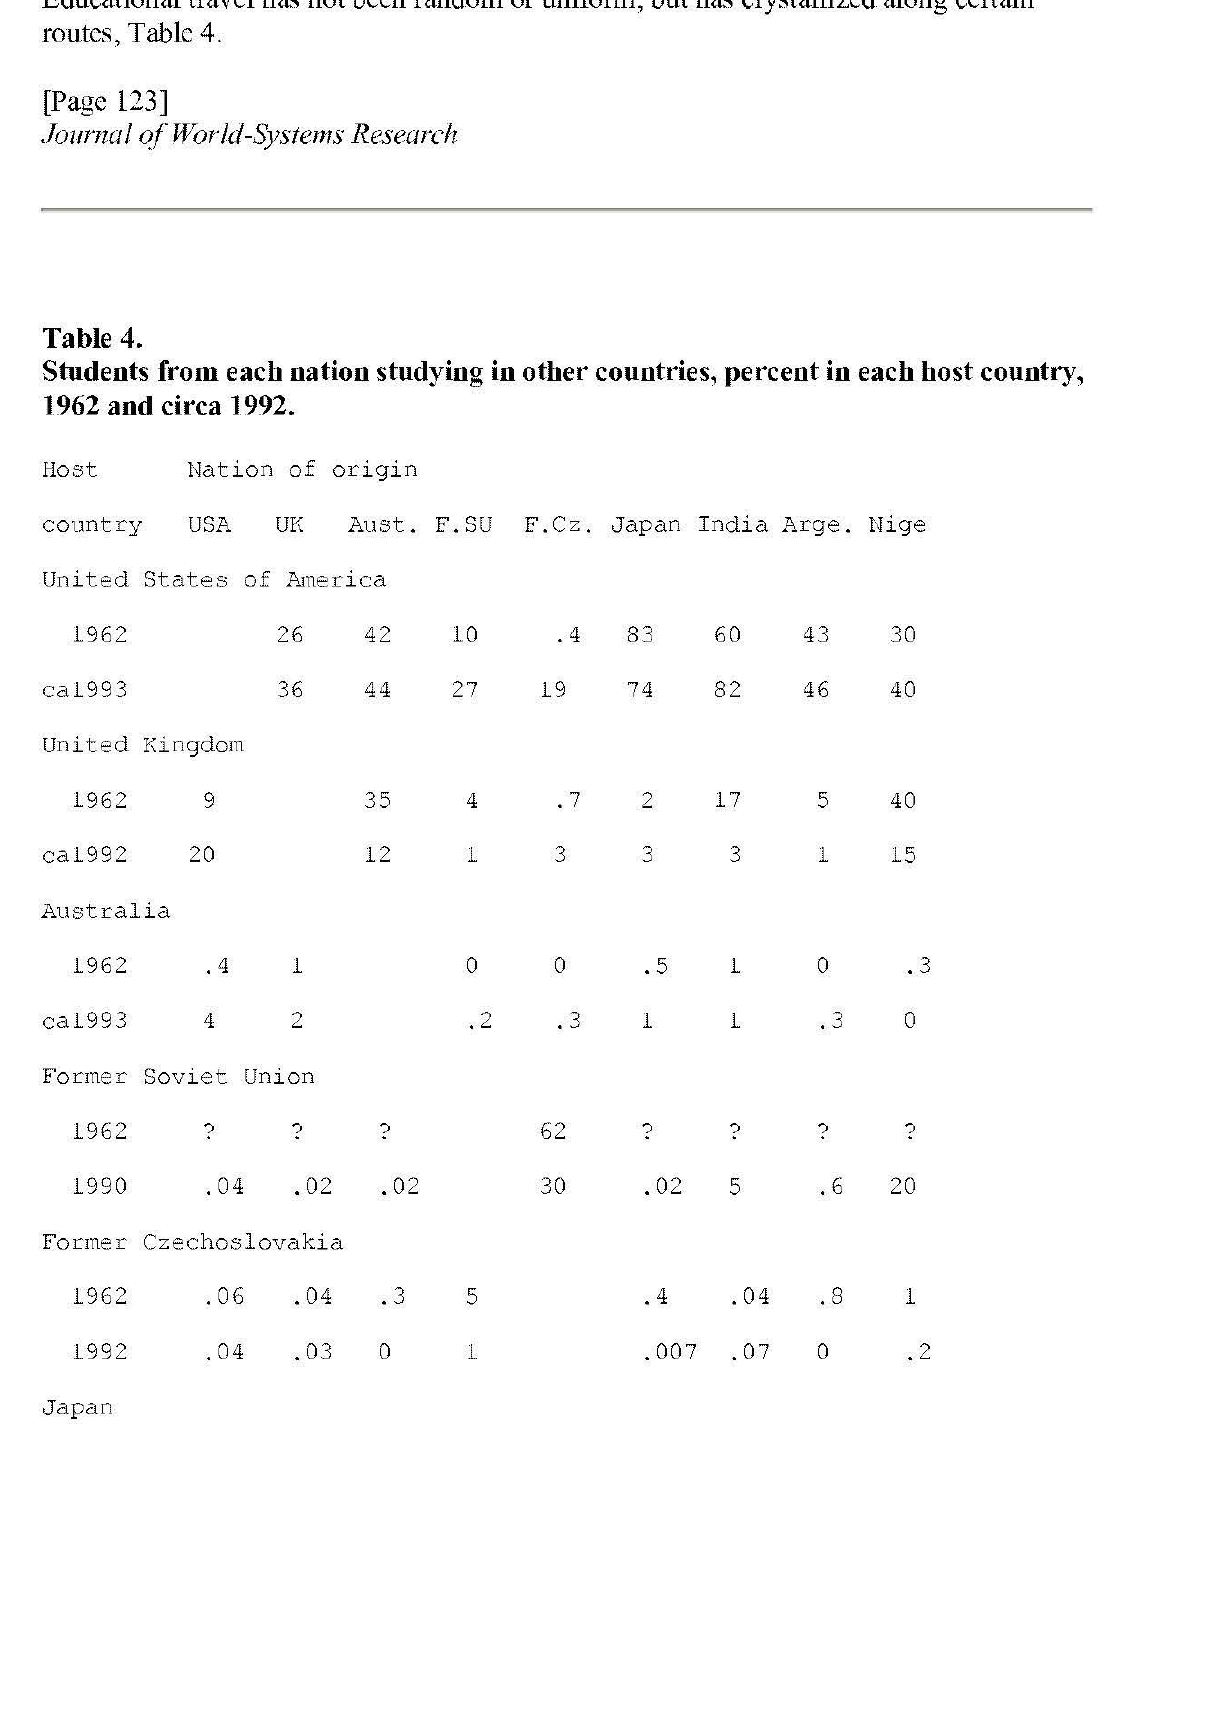
Students from each nation studying in other countries, percent in each host country, 1962 and circa